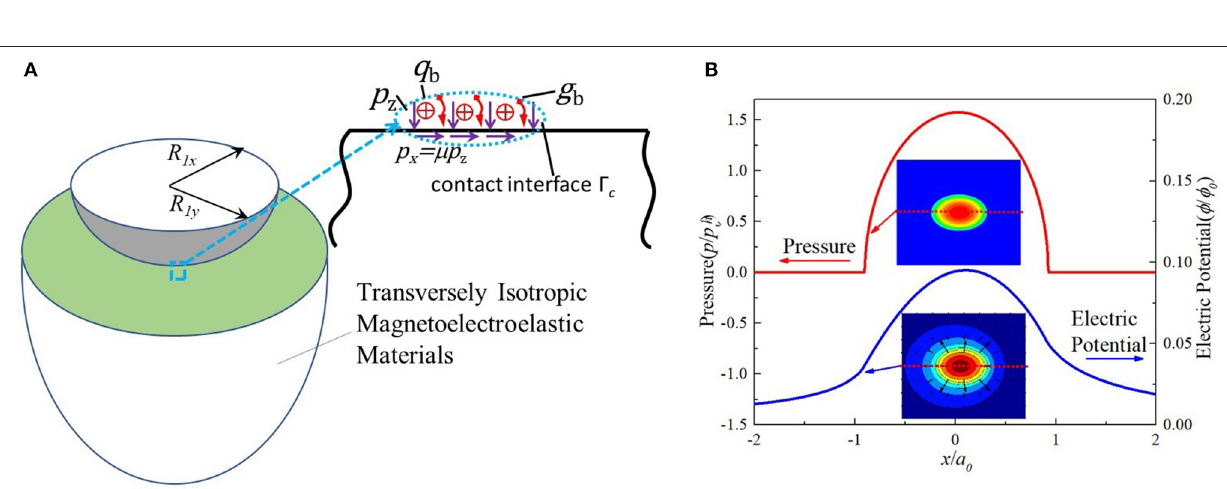
Frontiers in Mechanical Engineering | www.frontiersin.org